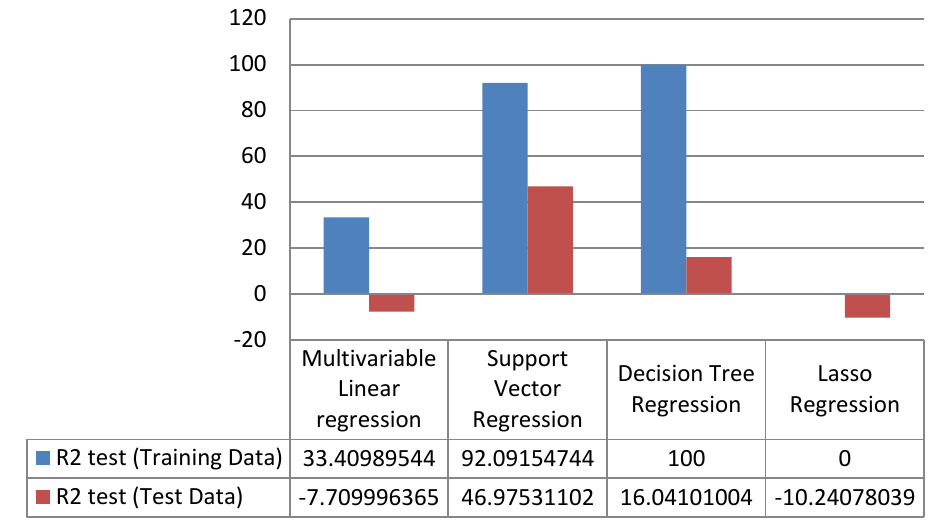
Figure 5. R 2 result for pH.